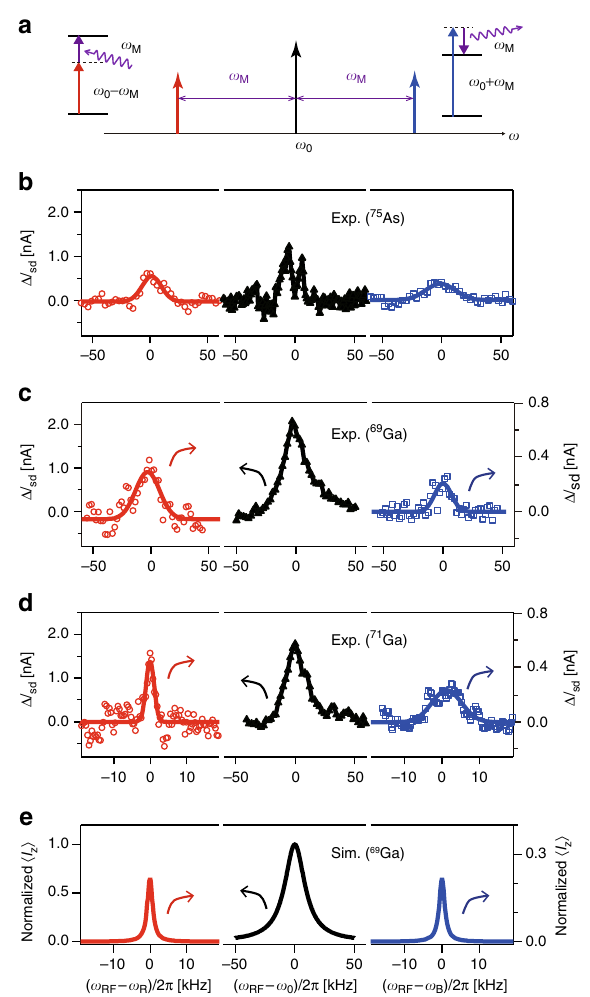
Fig. 2 NMR sidebands induced by electromechanical phonons. a A red (blue) sideband NMR peak can be induced with the absorption (emission) of an electromechanical phonons. b – d The main and red/blue sideband NMR spectra with relevant isotopes, 75 As, 69 Ga, and 71 Ga from top to bottom, respectively. Each panel shows Δ I sd as function of ω RF with ω R(B) = ω − ( + ) ω ω 75 As)/2 π = 22.63 MHz, ω 69 Ga)/2 π = 31.79 MHz, 0 M , where 0 ( 0 ( and ω 0 ( 71 Ga)/2 π = 40.39 MHz at B 0 = 3.1 T when the resonator is driven with V a = 40 mV at point 5 in Fig. 3a. The solid lines in the sideband NMR spectra show Gaussian fi ts of the data. e The simulated NMR spectra for 69 Ga using the rotating-wave approximation, which are normalized by the amplitude of the main NMR peak (see